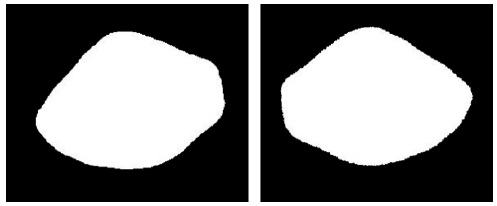
Figure 6. Gemstone image before and after rotation operations.